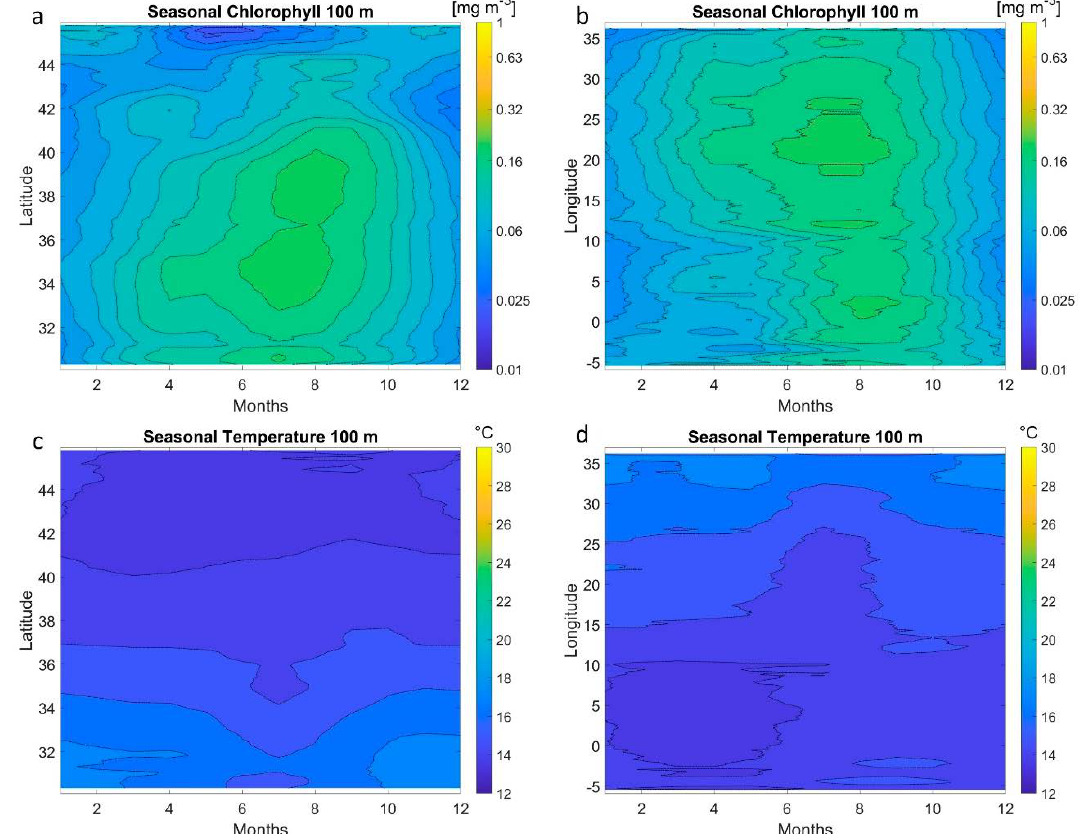
Figure 14. An example of MLP basin reconstruction from monthly satellite data at 100 m of depth. On the left panels a contour plot of the longitudinal chlorophyll ( a ) and temperature ( c ) means along the year (on x-axis) is shown. On the right, a corresponding contour plot of latitudinal chlorophyll ( b ) and temperature ( d ) means is provided.